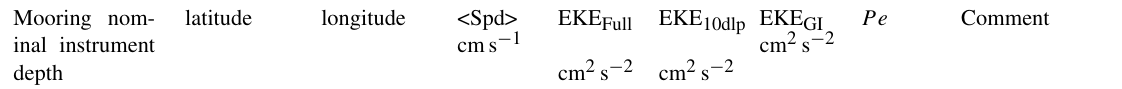
Table 1. Eulerian EKE: statistics in the subpolar North Atlantic SPNA. BODC: British Oceanographic Data Centre (https://www.bodc.ac.uk/, last access: March